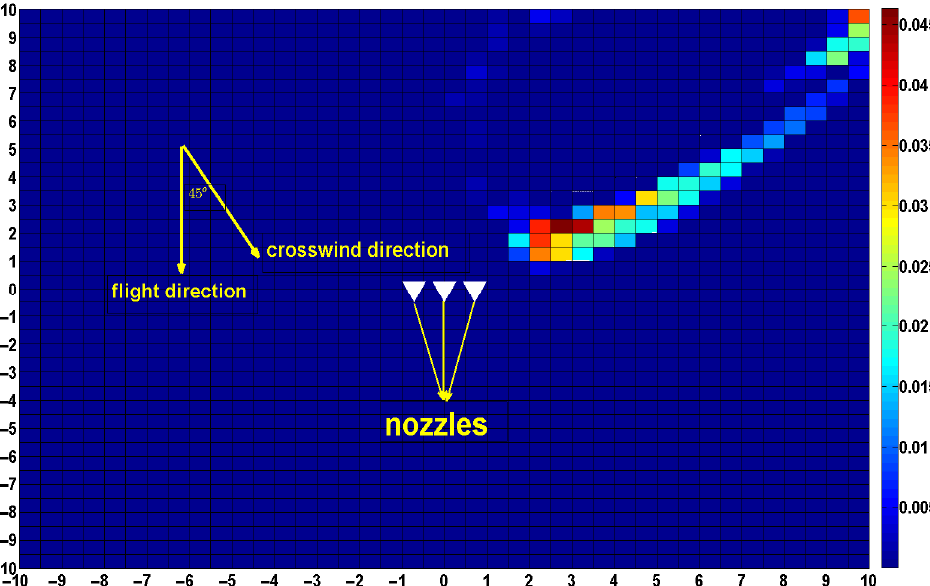
Figure 21. Droplet deposition distribution at a flight height of 3 m, crosswind speed of 2 m/s, crosswind and flight angle of 45°, and a flight speed of 1 m/s.